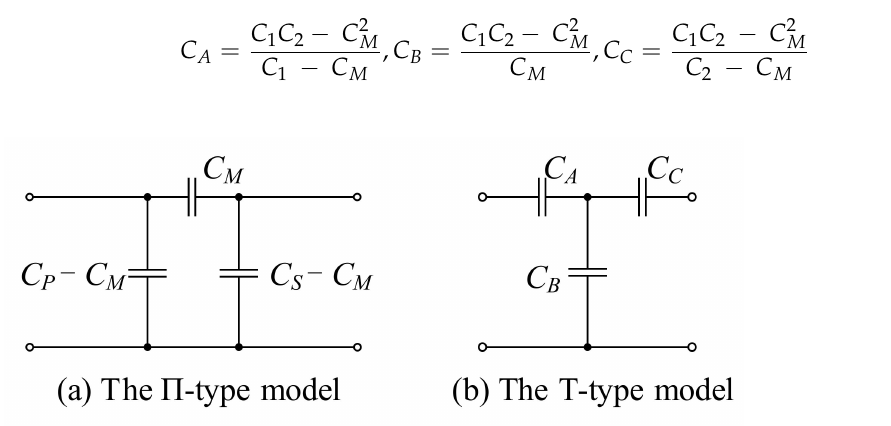
Figure 2. The equivalent model of the capacitive